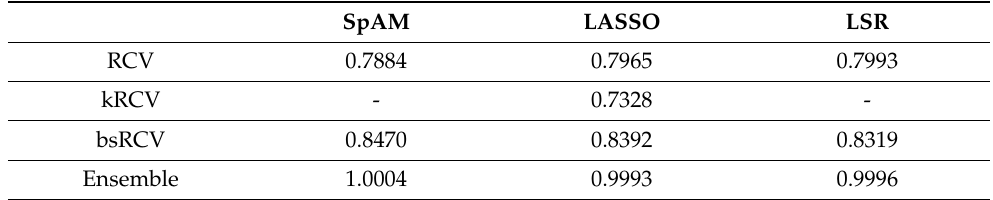
Table 3. Error variance estimation in wheat